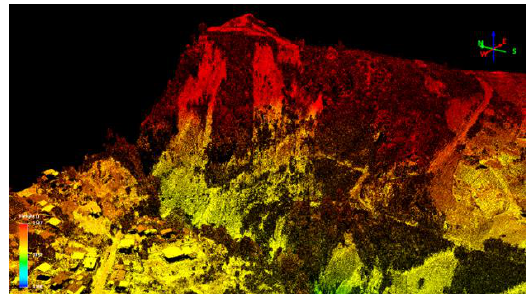
Figure 2. Close-up point clouds view of landslides area QuickBird satelite images was used for this study. This satellite image was derived from DigitalGlobe satellite which can give up to sub-meter level for panchromatic image and 2.4 m spatial resolution for multispectral image. QuickBird has a stable platform for precise location measurement that allows a high geolocational accuracy. In addition, its vast view is due to its off-axis unobscured design of